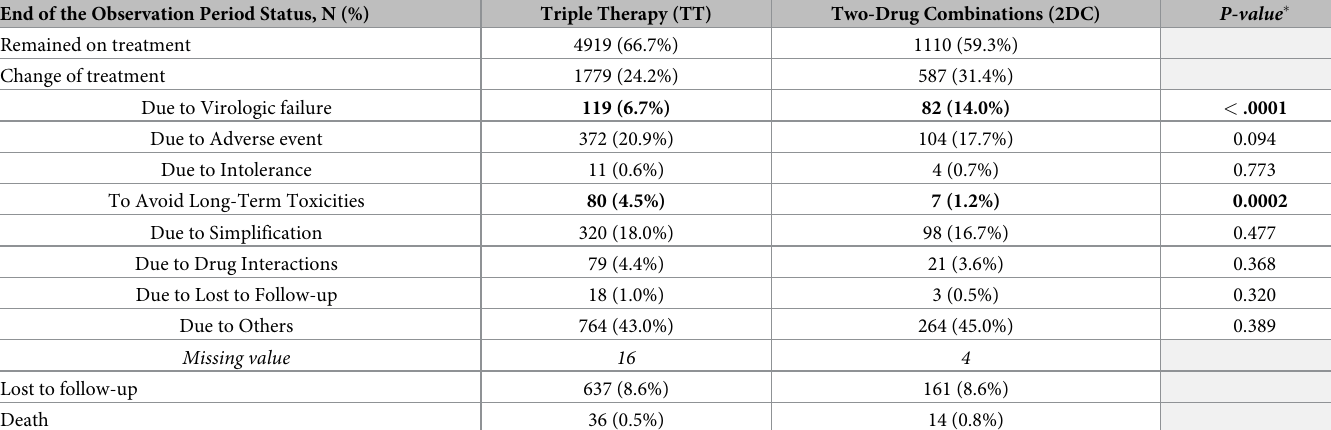
Table 3. Status at end of observation period, overall sample, by treatment group.